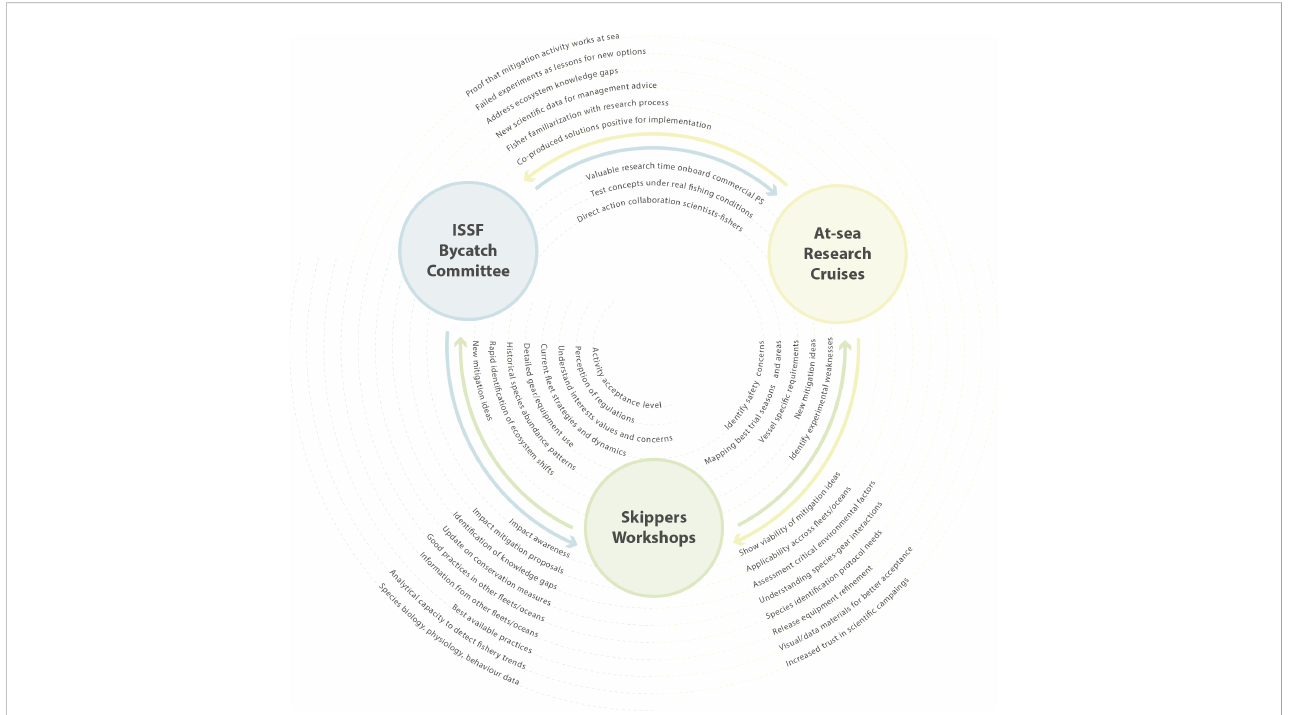
FIGURE 1 Flow chart between the three elements of the ISSF Bycatch Project: (1) Scienti fi c Bycatch Committee, (2) Skippers Workshops, and (3) research